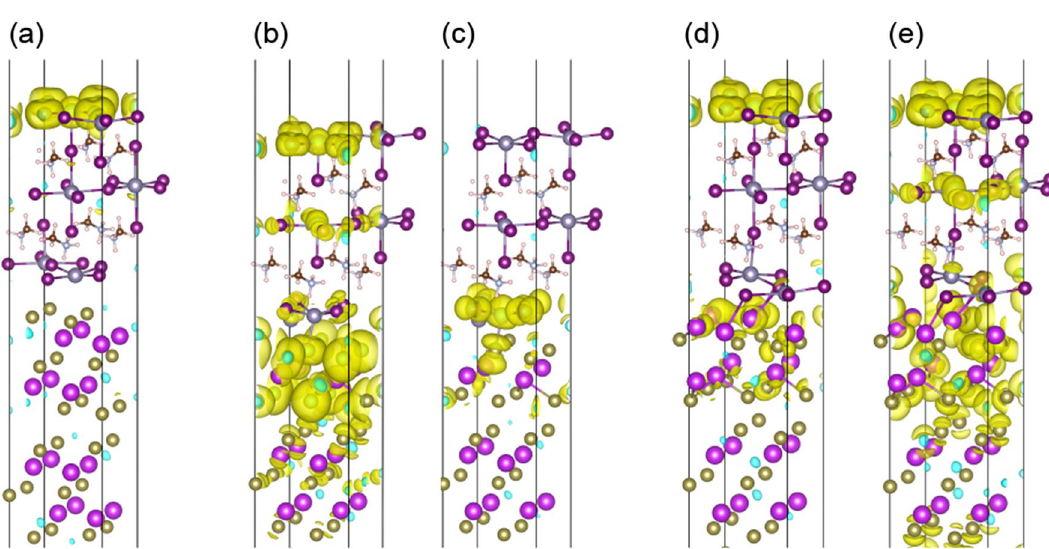
Figure 6. Visualization of charge distributions at selected energy levels for ( a ) Bi 2 Te 3 (Te I )/MASnI 3 ; ( b ) and ( c ) Bi 2 Te 3 (Te II )/MASnI 3 ; ( d ) and ( e ) Bi 2 Te 3 (Bi)/MASnI 3 . The indicated energy ranges are − 0.2 to 0.2 eV for ( a ), ( b ), and ( d ); 0.2–0.5 eV for ( c ); and − 0.5 to − 0.2 eV for ( e